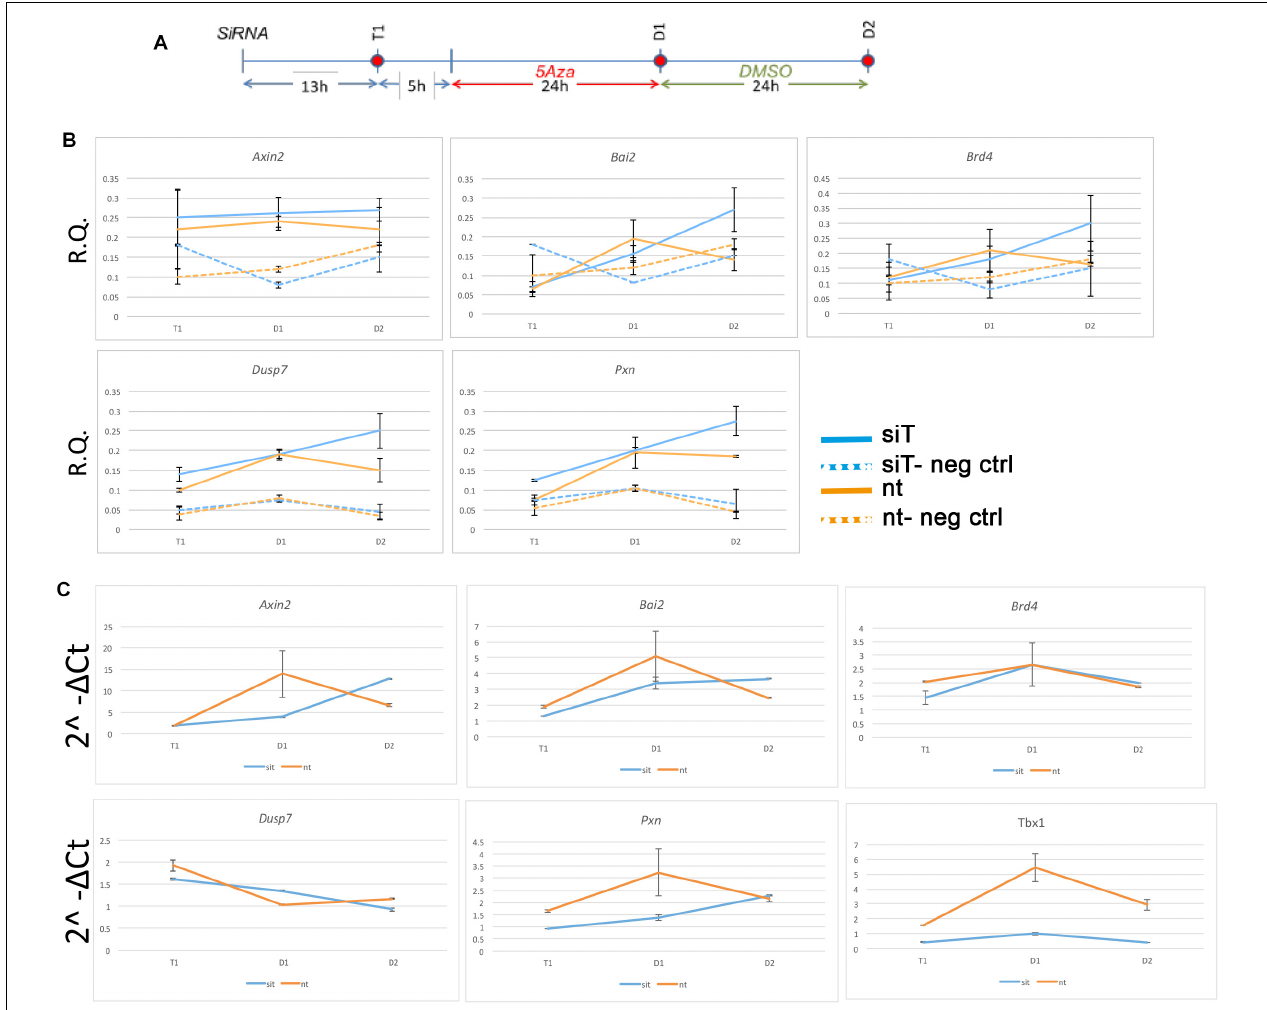
FIGURE 4 | Changes in chromatin accessibility during differentiation in P19Cl6 cells. (A) Experimental scheme illustrating the three time points tested, T1 (13 h after transfection of siRNA), D1 (24 h after 5Aza addition to the media), and D2 (24 h after addition of DMSO to the media). (B) Quantitative ATAC assays of previously identified TBX1 binding sites associated with the genes indicated. All sites were found to be accessible by ATAC-seq. In all cases, accessibility tends to increase at D2. The negative control locus is located in a gene desert region (see Table 2 for primers sequences). Values are the average of two biological replicates ± standard deviation. (C) Gene expression analysis by quantitative real time PCR of the same genes. Values are the average of two biological replicates ± standard error of the